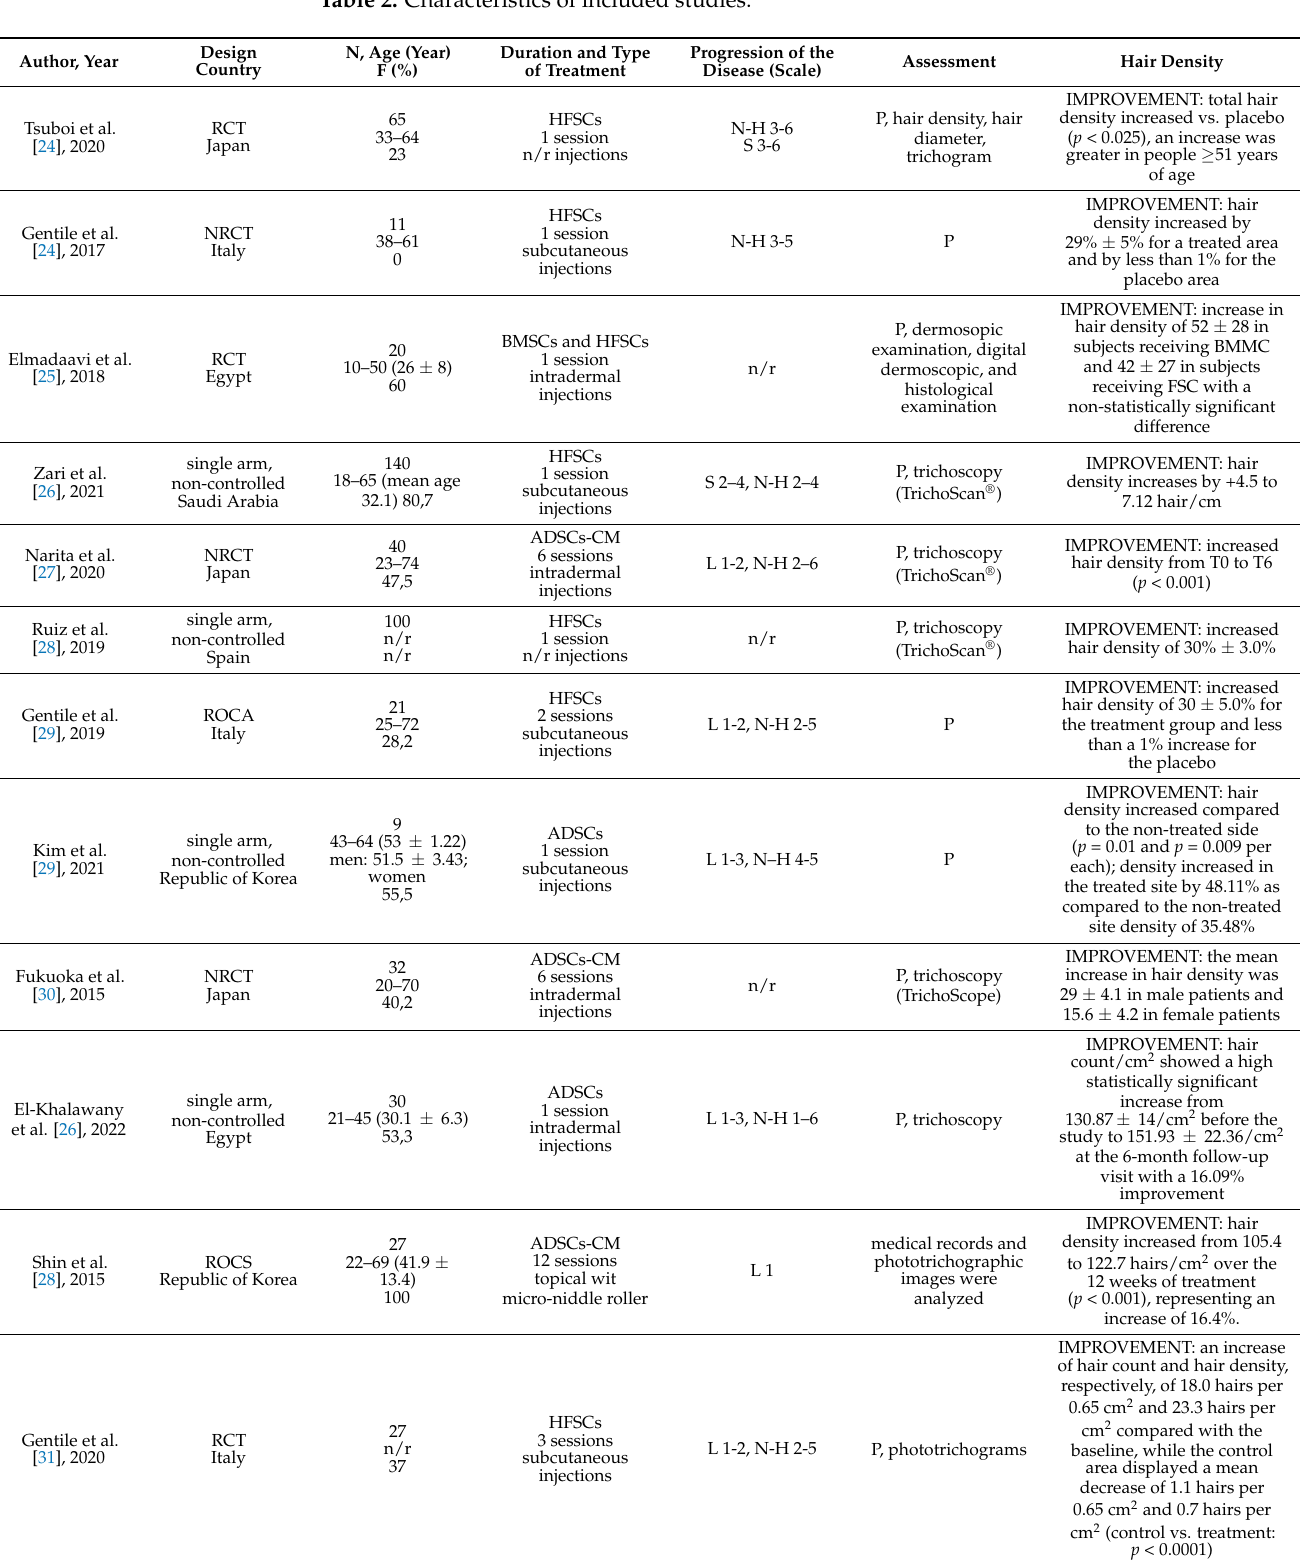
Table 2. Characteristics of included